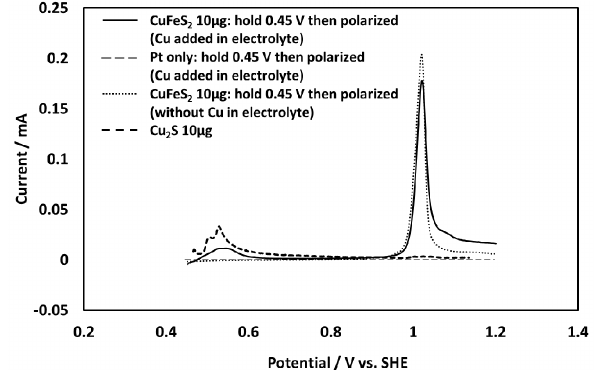
Figure 6. Voltammogram with or without 10 µg of chalcopyrite that is attached to the platinum plate surface and was held at 0.45 V for 300 s before the potential was polarized in the anodic direction at a 1 mV·s − 1 scan rate under ambient conditions. The electrolyte is 0.1-M H 2 SO 4 with or without 0.01-M Cu 2+ . The chalcocite potential polarization results that are shown in Figure 5B are added to this graph for comparison.